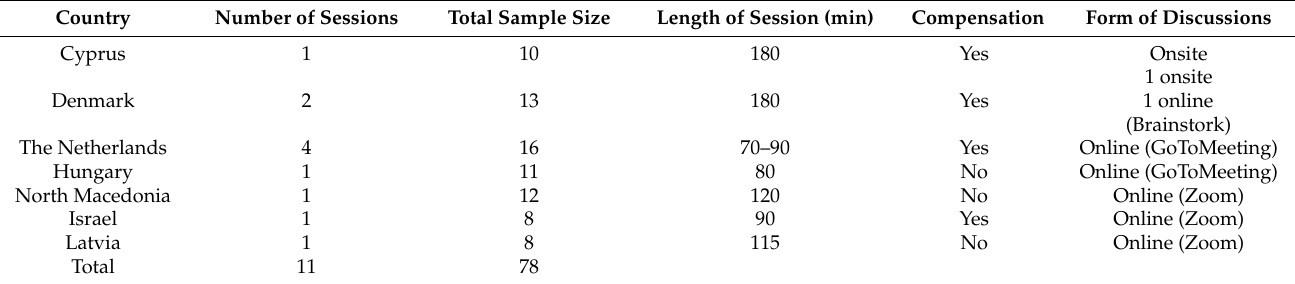
Table 1. Description of the focus groups discussions by